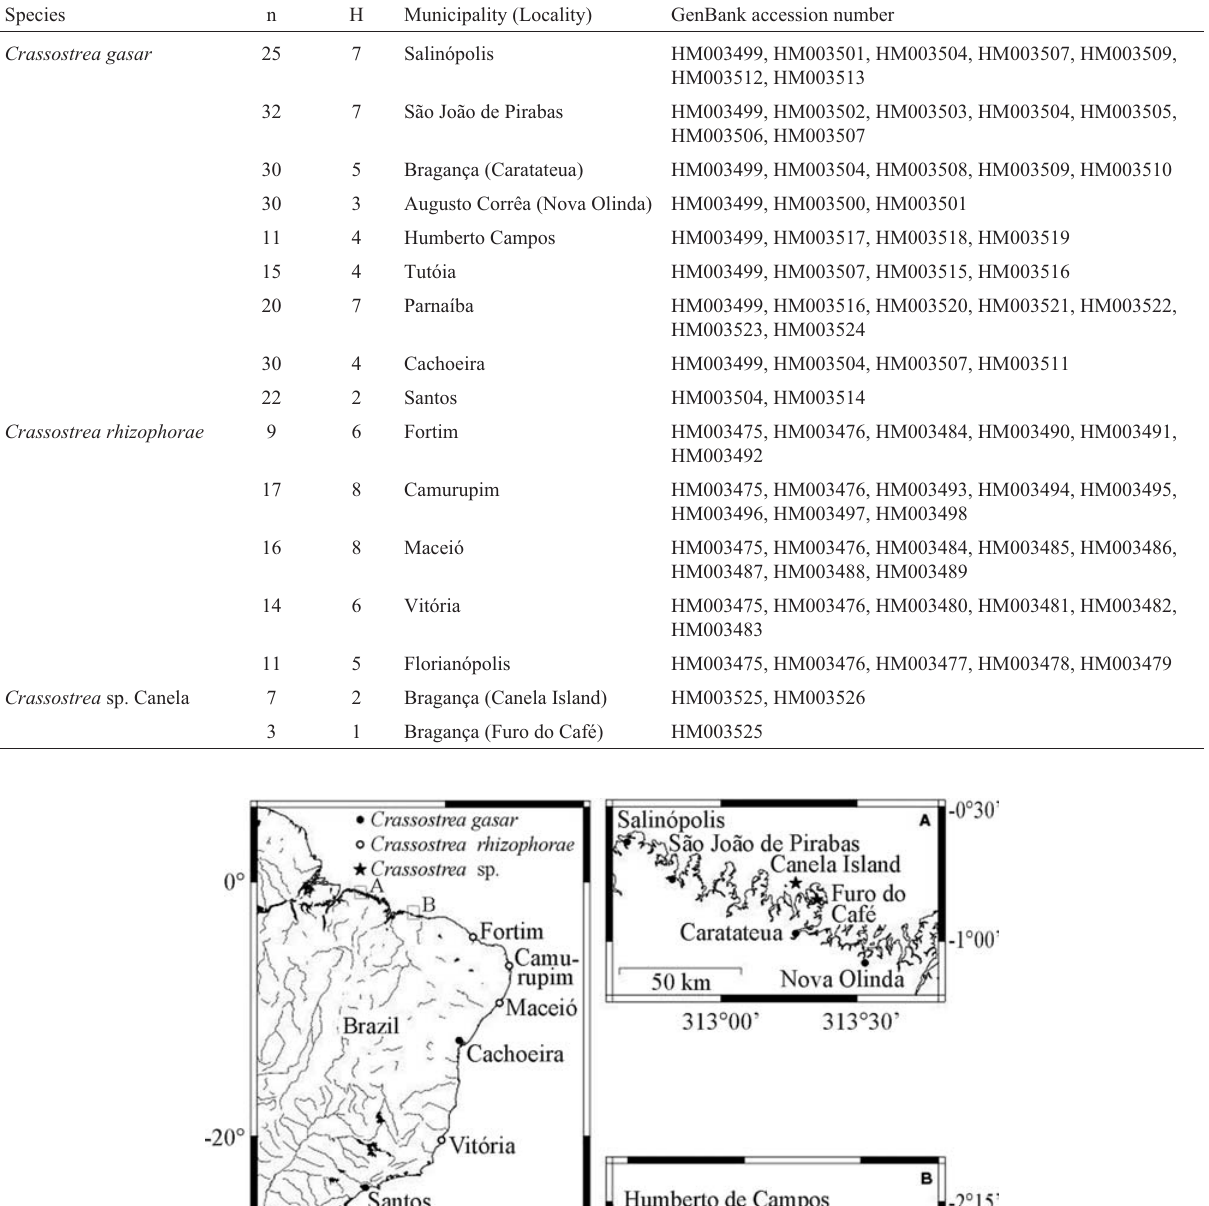
Table 1 - Species, sample size (n), number of COI haplotypes (H), sampling location and GenBank accession number of Brazilian oysters used in the present study. Species